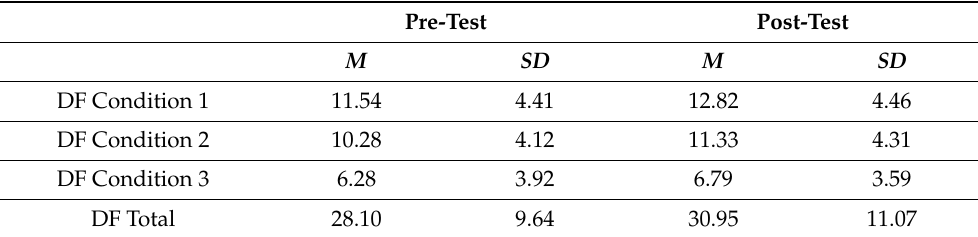
Table 3. Descriptive statistics for executive function scores (Study